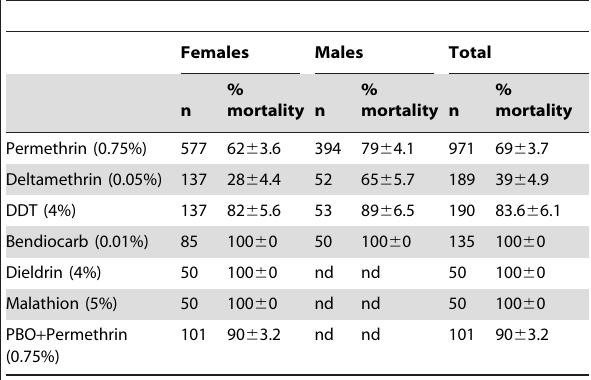
Table 2. WHO susceptibility test results on 2–5 day old F 1 An. funestus from